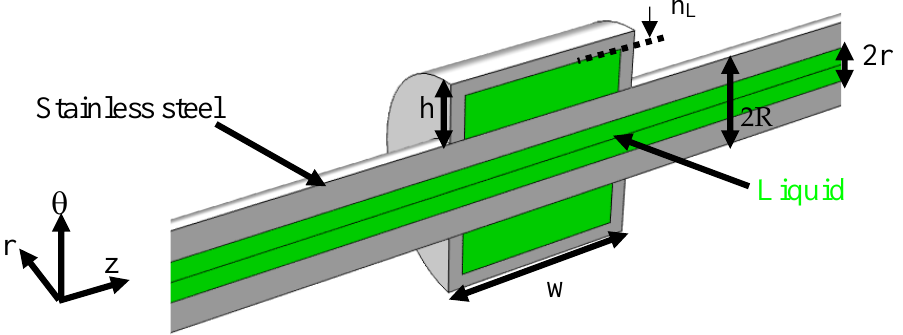
Figure 1. 2D cross-section view of the acoustic liquid sensor composed of a hollow cylindrical washer surrounding a hollow tube. The green and grey parts, respectively, represent the liquid and solid materials.